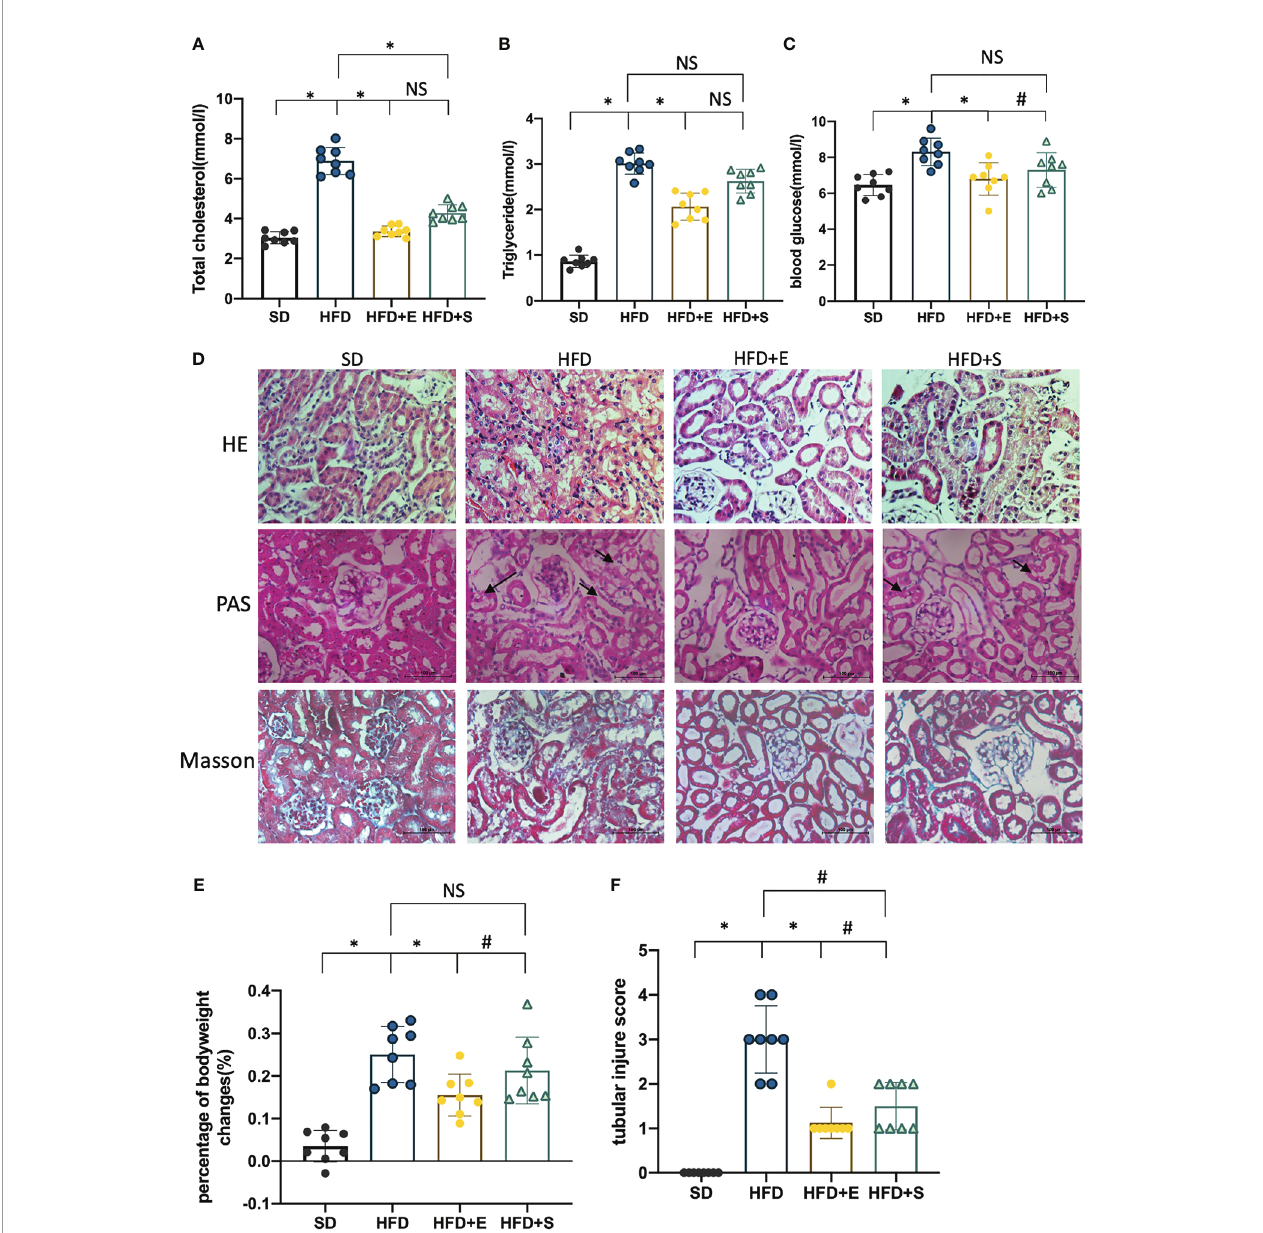
FIGURE 1 | Exenatide improves HFD-induced weight gain, dyslipidemia and renal tubular injury in mice. (A – C, E) Effects of exenatide and simvastatin on TC, TG, blood glucose and body weight changes in HFD mice. (D) H&E, PAS and Masson-trichrome staining of the kidney, arrowheads indicate vacuolation changes in TECs (original image magni fi cation: ×200, bars =100 m m). (F) Quanti fi cation of tubular injury. Data are presented as the mean ± SD (n=8). SD, standard diet; HFD, high-fat diet; HFD+E, HFD with exenatide treatment; HFD+S, HFD with simvastatin treatment. * P < 0.01 versus HFD group. # p < 0.01 versus HFD+E group. NS no statistical difference between